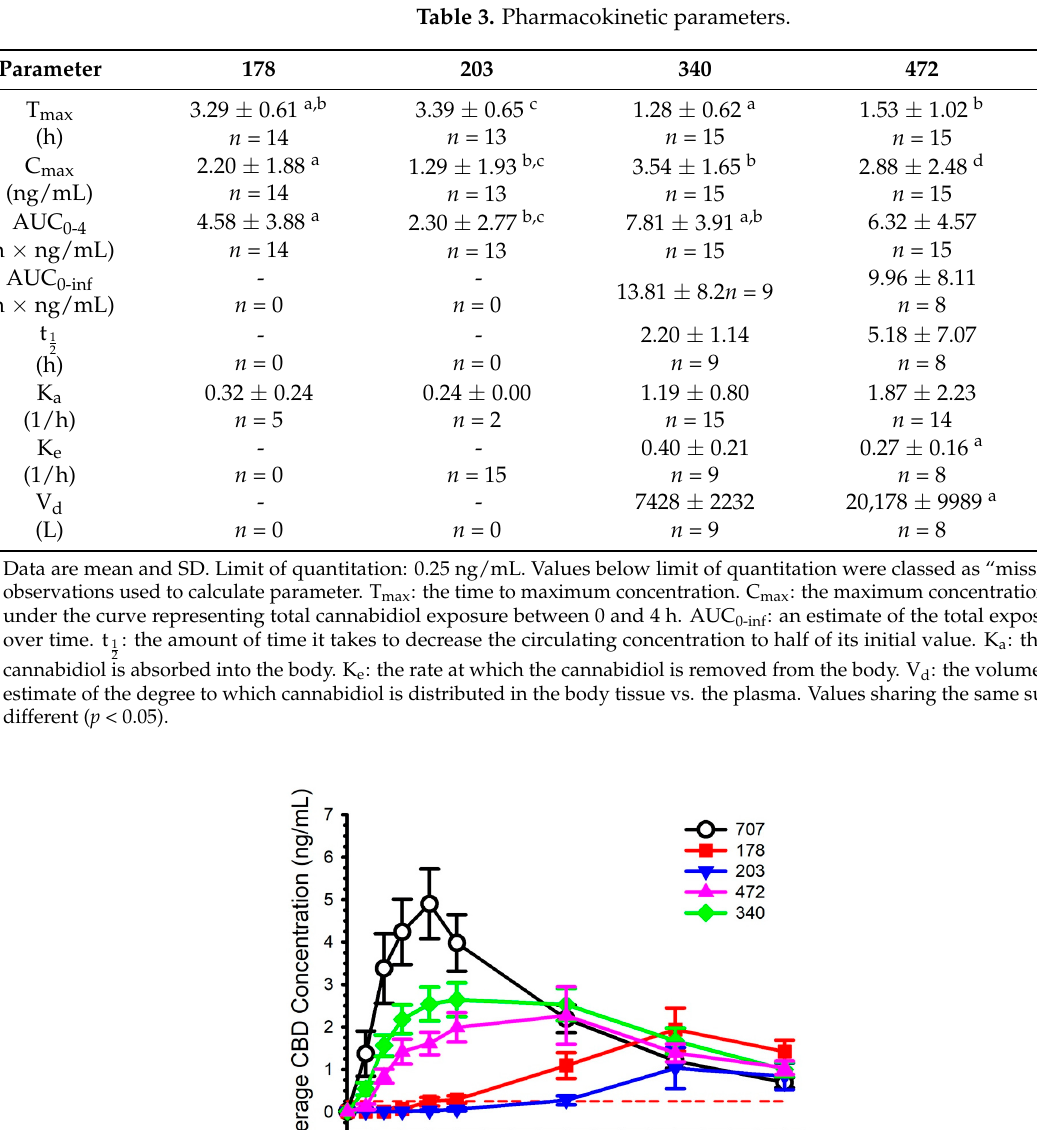
Table 3. Pharmacokinetic parameters.